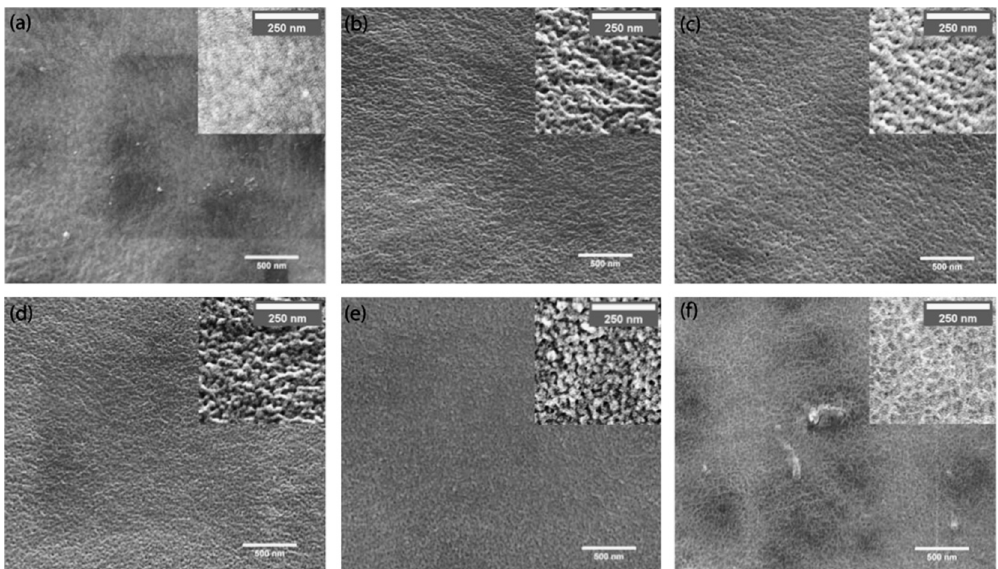
Figure 2. Outside surface morphology of hallow fiber membrane containing 18 wt.% PSF (HFM18) with different oxidized MWNTs content: ( a ) 0 wt.%; ( b ) 0.1 wt.%; ( c ) 0.25 wt.%; ( d ) 0.5 wt.%; ( e ) 0.75 wt.% and ( f ) 1.0 wt.%. (Reproduced with permission after [31]).